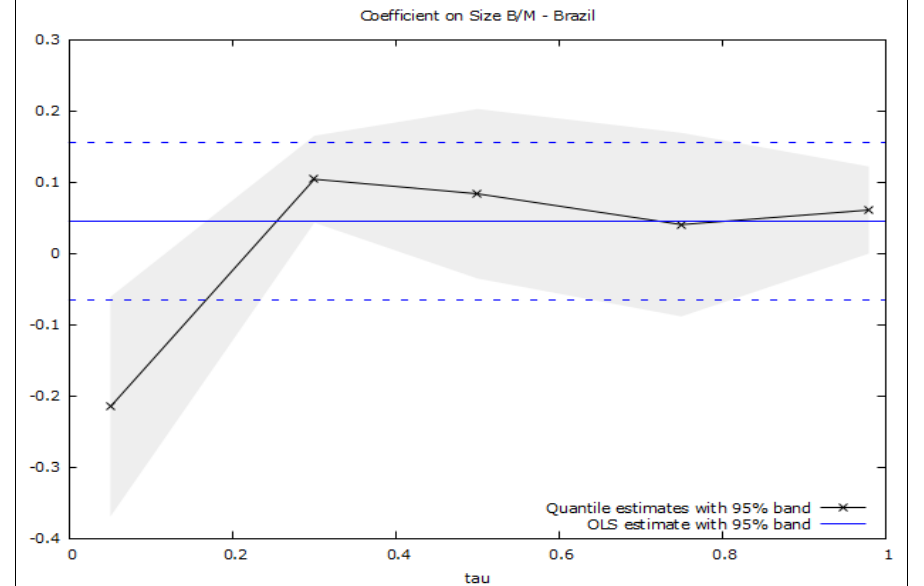
Figure A2. Performance of the SMB B/M risk factor on the percentiles and conditional average of Brazil’s GDP growth rate.